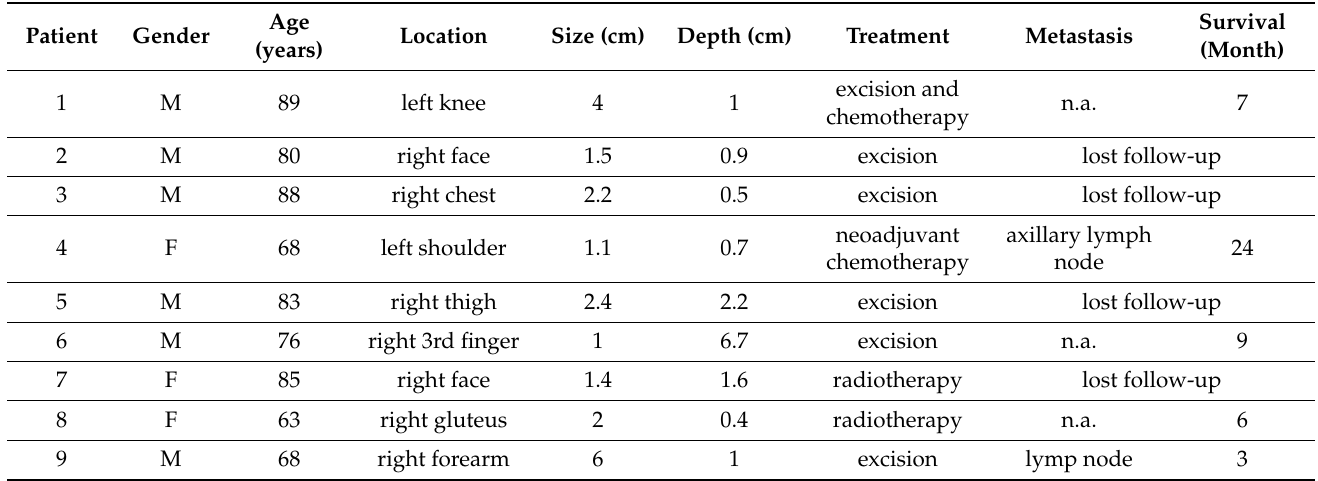
Table 1. Oncological characteristics of the Merkel cell carcinoma patients.